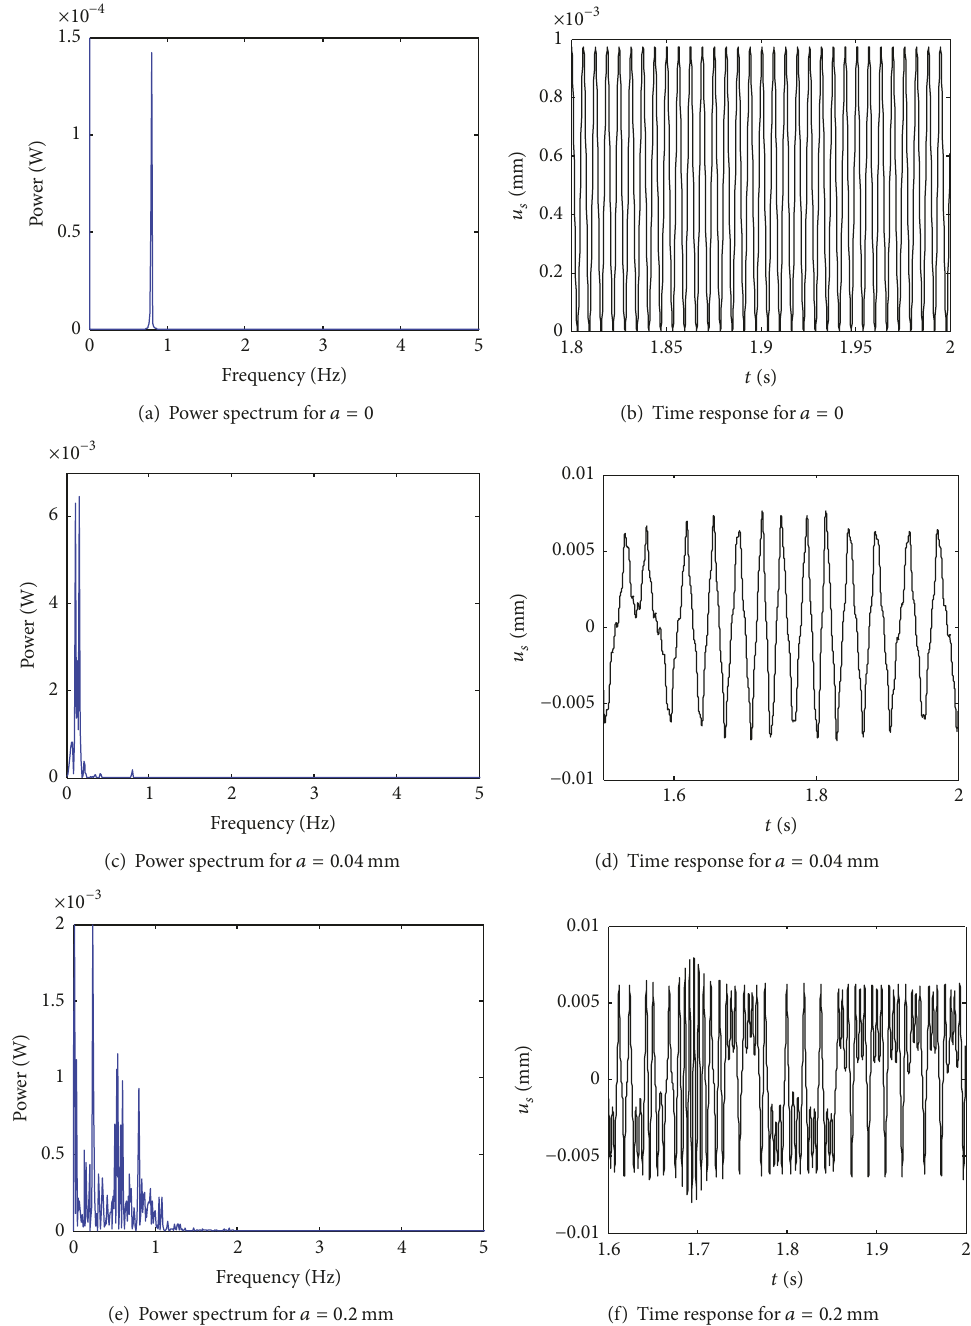
Figure 16: Power spectrum and time response of wave generator for different wave generator offset.